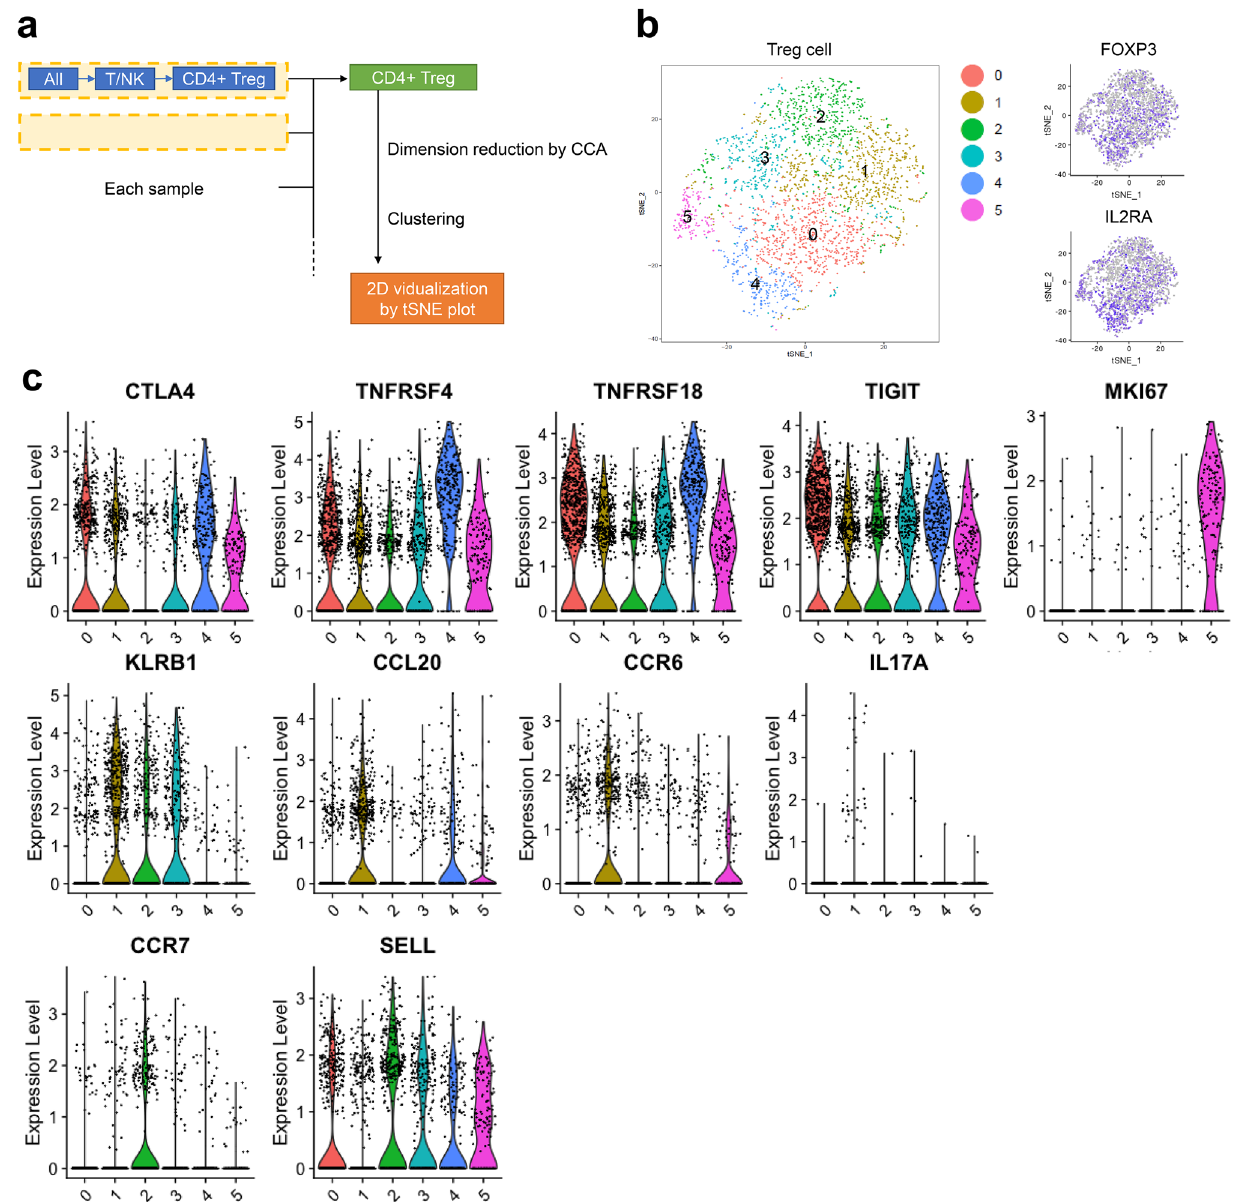
Figure 5. ScRNA-seq revealed Treg cells in the TME have heterogeneity. ( a ) The procedures followed for the data processing. Briefly, the Treg-cell population was extracted from each sample as FOXP3 + CD25 + CD4 + T cells, concatenated, and analyzed. ( b ) t-SNE plot (left) and gene expression feature plot for Foxp3 (right, top) and IL2RA (right, bottom) of concatenated Treg cells. Six clusters of Treg cells were identified in the TME. ( c ) Violin plots showing the gene expression of Treg cells in the TME of representative